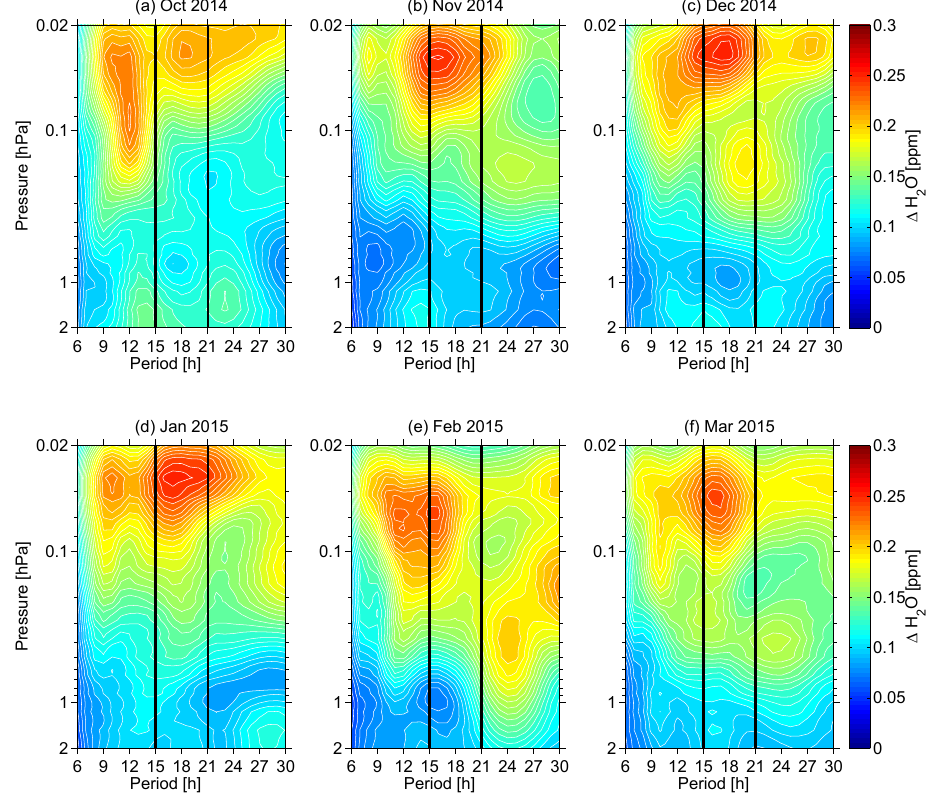
Figure 5. The MIAWARA water vapor monthly mean wave spectrum with periods between 6 and 30h. Shown is the result of the H 2 O amplitudes (ppm) for the months October 2014 to March 2015 (a–f) . The border of the quasi 18h period band (15–21h) is indicated by the vertical black line